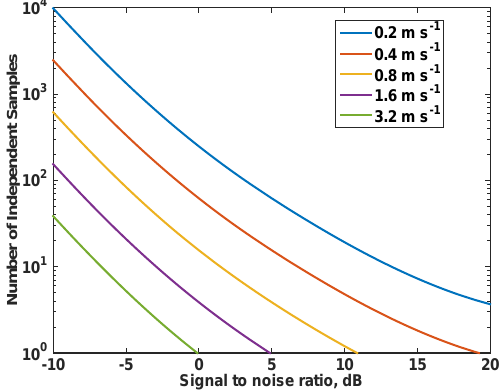
Figure 5. Velocity accuracy as a function of independent samples and signal-to-noise ratio. Spectrum width is assumed 1ms − 1 , PRF is 10kHz and transmit frequency is W